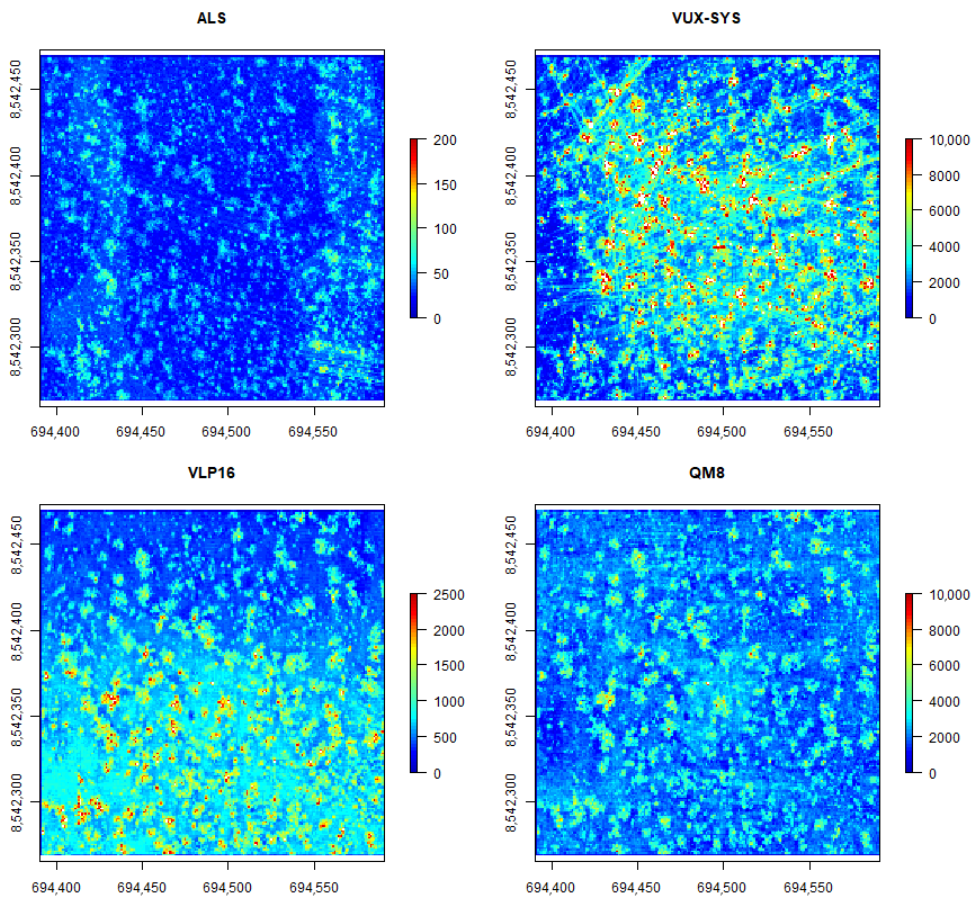
Figure 3. Point density plots, indicating the number of pts/m 2 . The area shown covers the 200 × 200 m study area; coordinates on the x and y axes are given in UTM Zone 52S. Note that colour scales are different per plot.